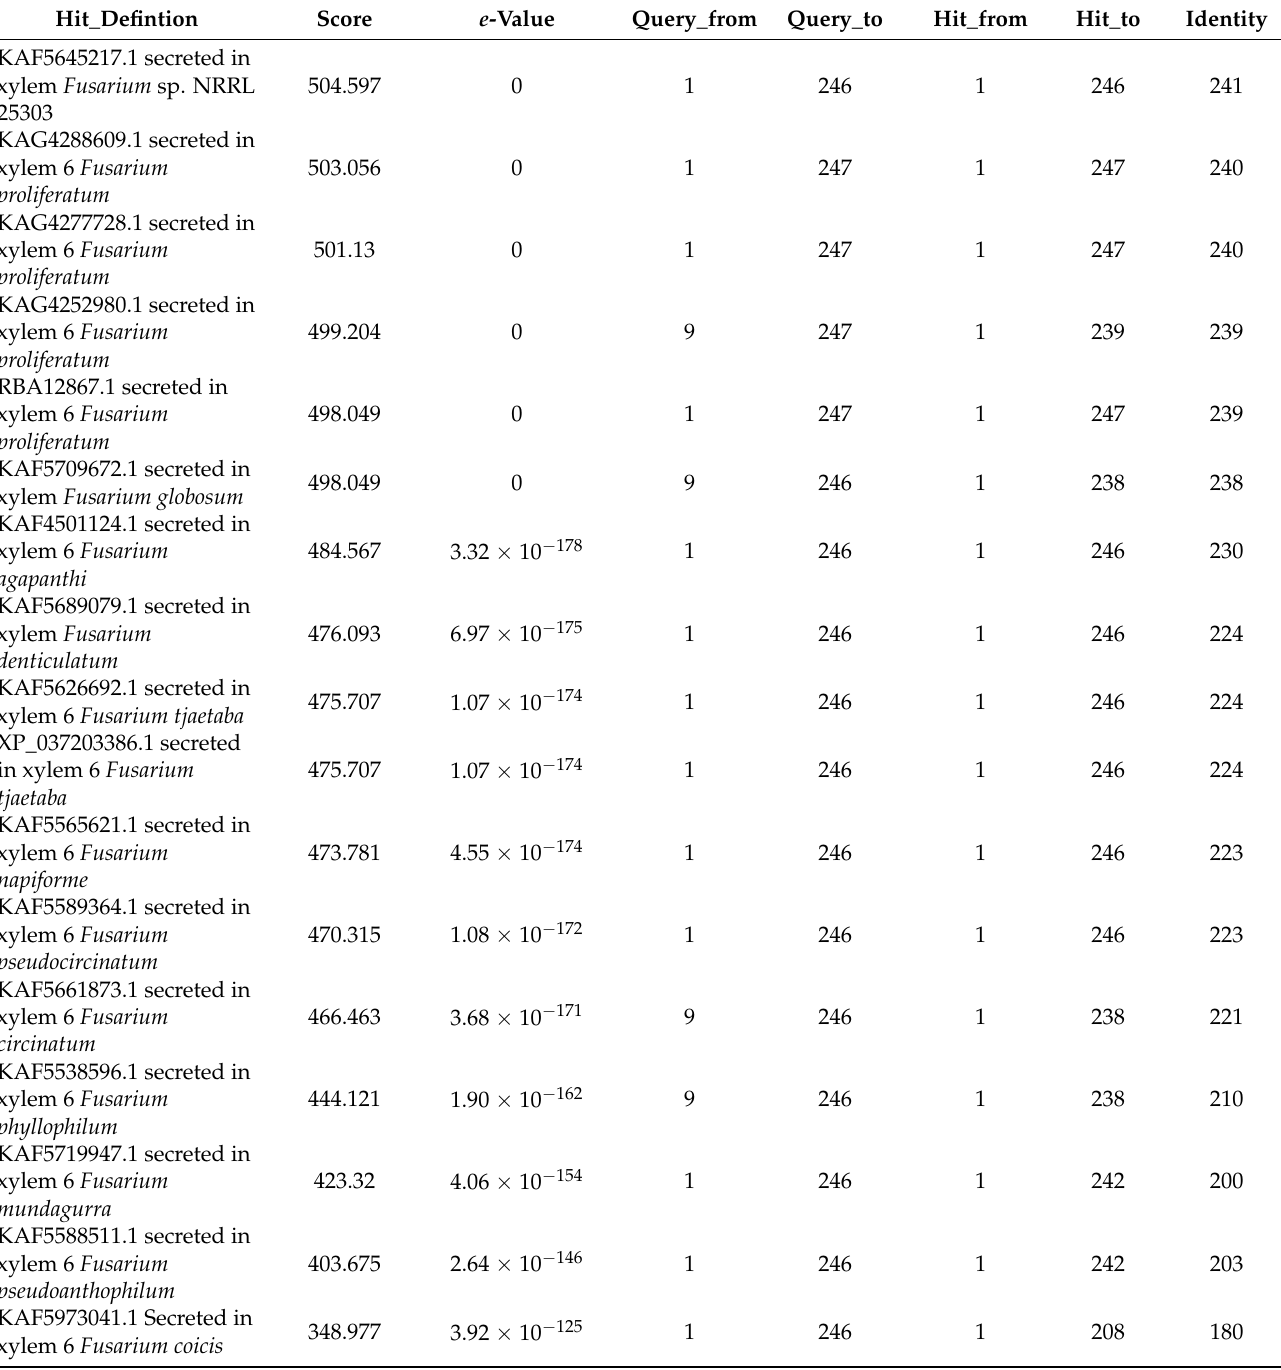
Table 3. Results of the BLASTp analysis using predicted SIX6 of